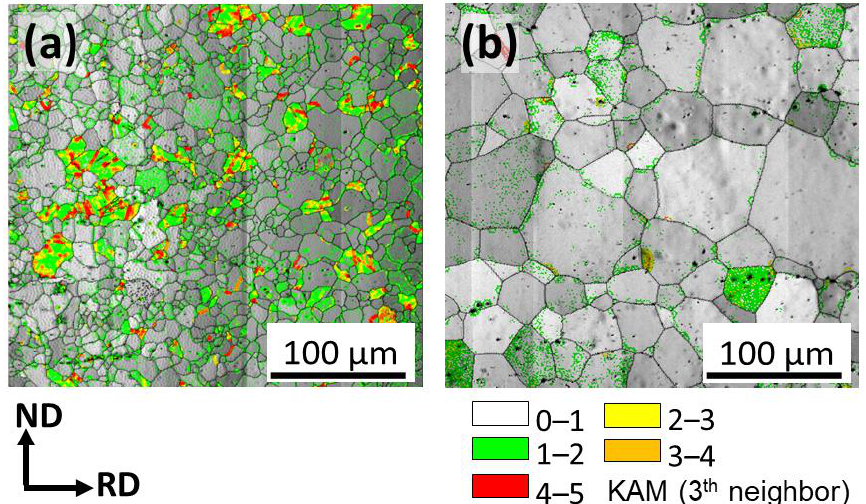
Figure 2. Microstructure of ( a ) ZX11-350 and ( b ) 450 samples using the kernel average misorientation (KAM).